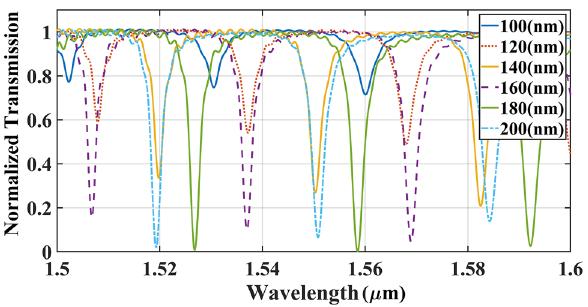
Figure 8. The effect of equal slot widths of the ring waveguide in the transmission spectrum considering the fixed parameters of Lc = 0 µm, gap = 180 nm , WSi_out = 190 nm, WSi_mid = WSi_in = 150 nm nm.